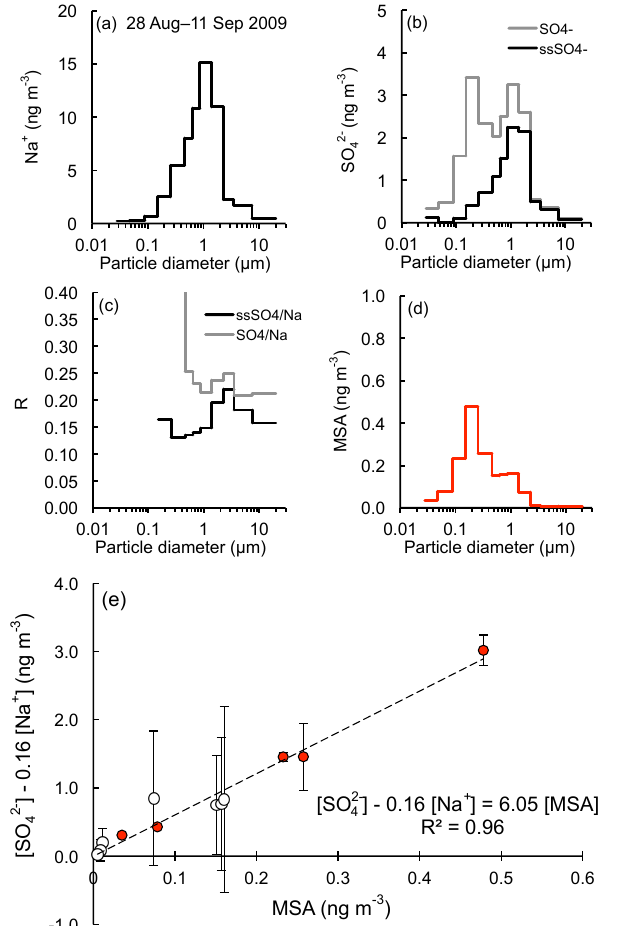
Figure 8. (a–d) Mass size distribution of Na + (a) , SO 2 − curve) and MSA (d) of the aerosol sampled at Concordia 28 August to 11 September 2009. Also plotted is the sulfate to sodium mass ratio ( R ) ( c , grey curve). The black lines on the panels of sulfate and sulfate to sodium ratio ( R ) refer to values of sea-salt sulfate calculated after having subtracting the biogenic contribution esti- mated from MSA (see panel e ). (e) Relationship between biogenic sulfate and MSA observed on the 12 stages of the impactor; the red points refer to values on the smaller particles (below 0.5µm diam- eter). The vertical bars denote uncertainties in calculating the bio- genic contribution by assuming a sulfate to sodium ratio in sea-salt aerosol ranging between 0.07 and 0.25 (0.16 ± 0.09) (Sect. 3.2).